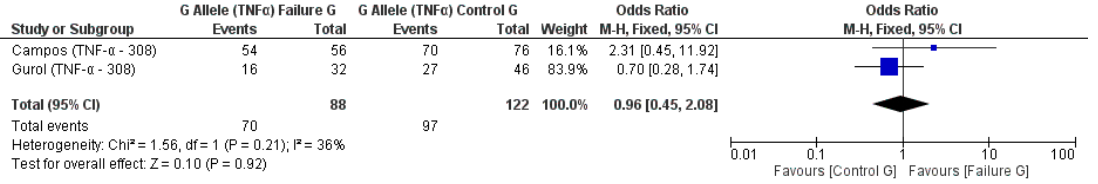
Figure 7. Odds ratio and forest plot for the prevalence of TNF- α -G308 allele in the failure group (at least one implant failure) vs. control group (without implant failure). The OR of the combined data crossed the line of no difference.